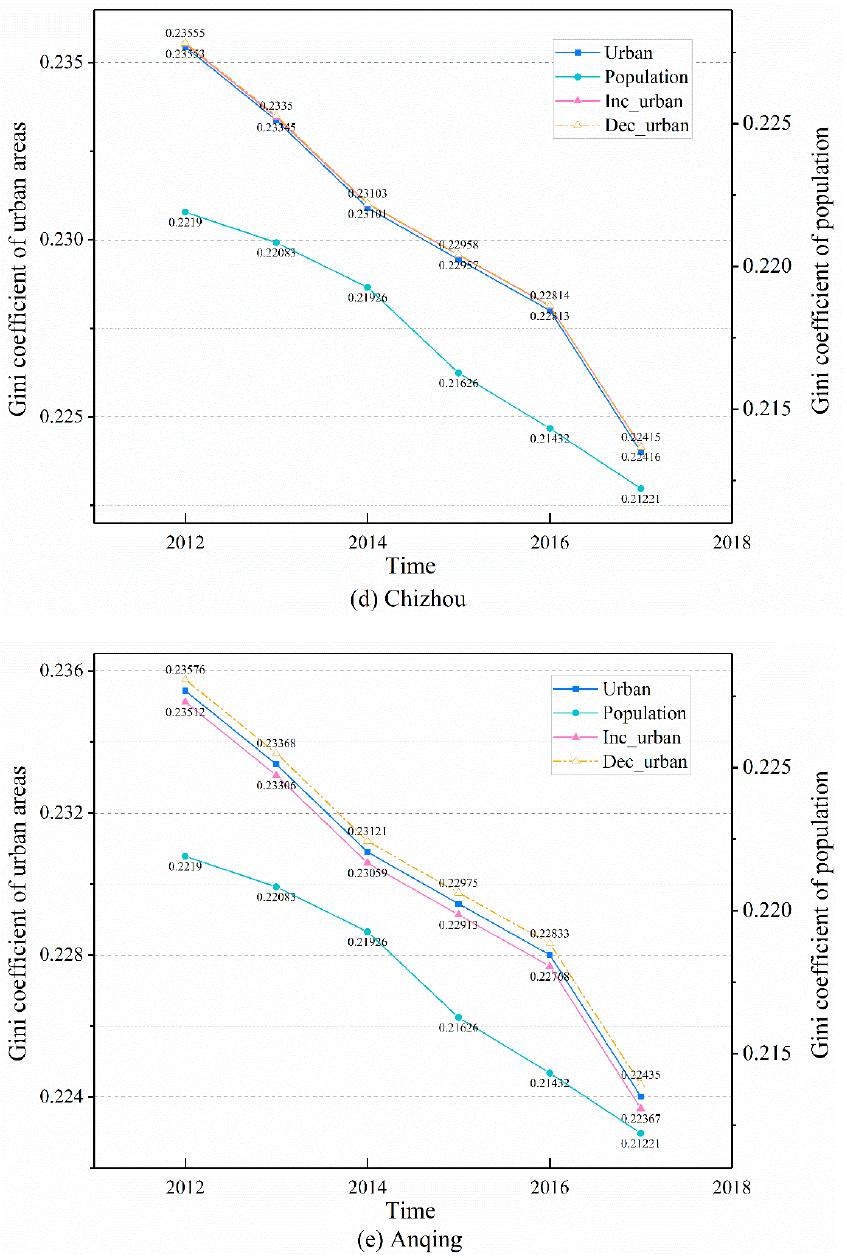
Figure 10. Variations in the Gini coefficient of the YRD from 2012 to 2017; The “Inc_urban” and “Dec_urban” represent the results calculated from urban areas of five cities that increased by 5% and decreased by 5%,